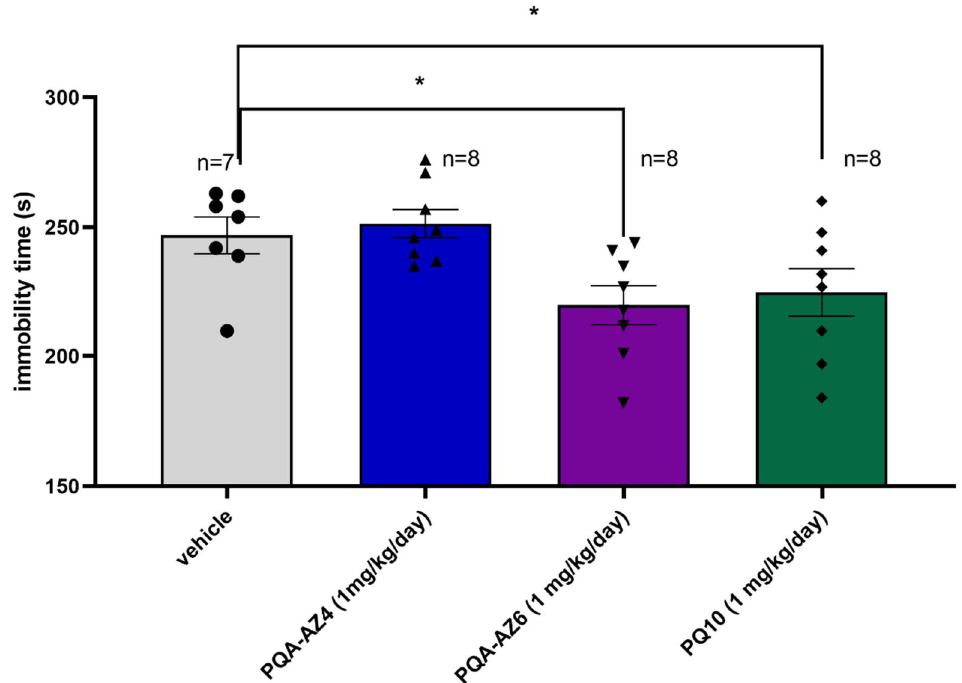
Figure 1. Effects of repeated administration of PQA-AZ4, PQA-AZ6, and PQ-10 on the duration of immobility in the FST in rats. PQA-AZ4, PQA-AZ6, and PQ-10 were administered i.p. once daily for 21 consecutive days. Data represent the mean ± SEM, n = 7–8 rats per group; one-way ANOVA followed by Bonferroni’s post-hoc test, * p < 0.05 vs. respective vehicle-treated group.